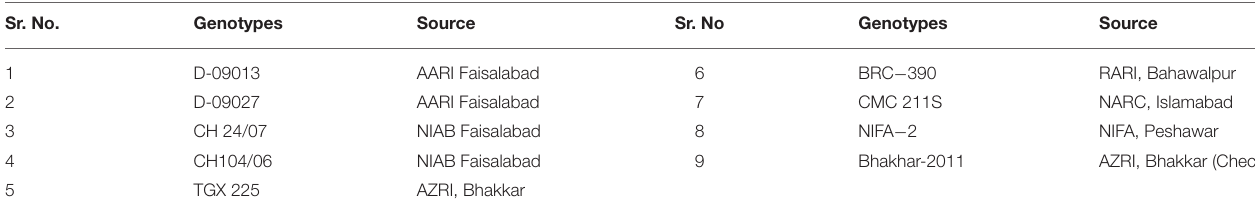
TABLE 1 | List of genotypes along with their source used in the study. Sr.